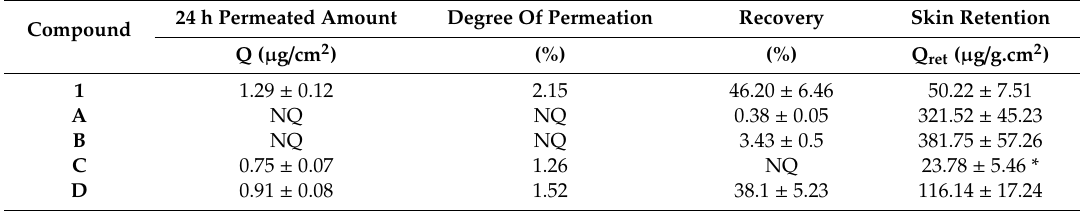
Table 2. Results of the permeation studies expressed by mean and SD ( n =